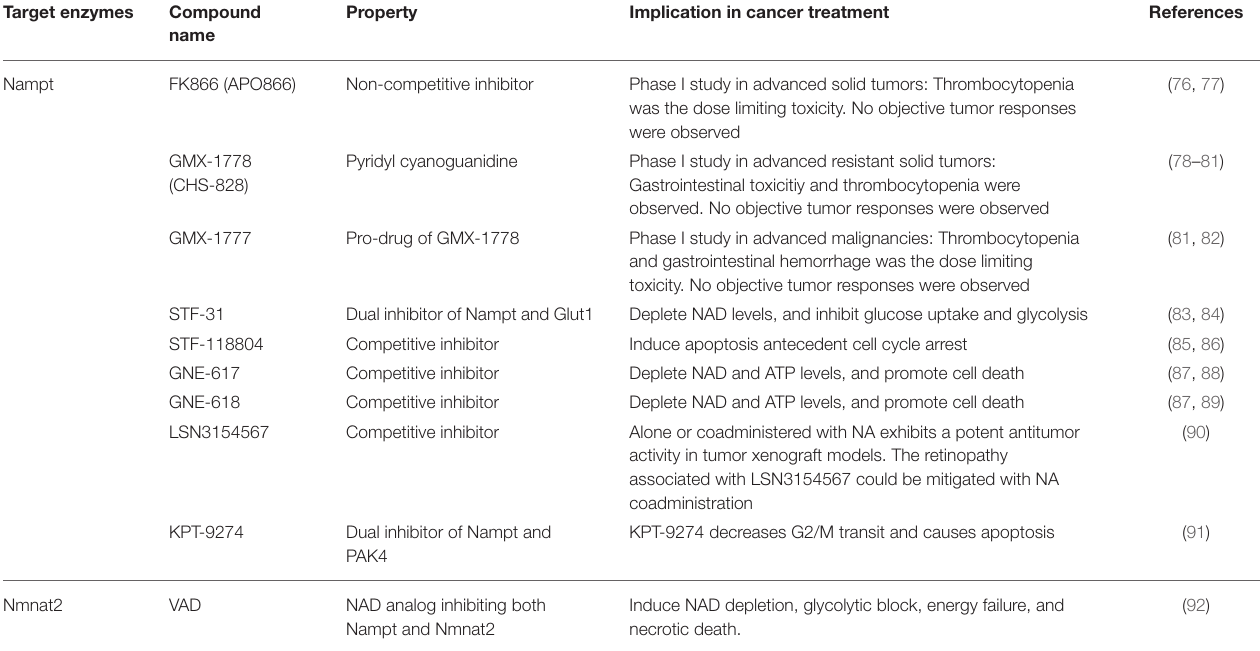
TABLE 1 | Small molecules targeting NAD synthesis enzymes. Target